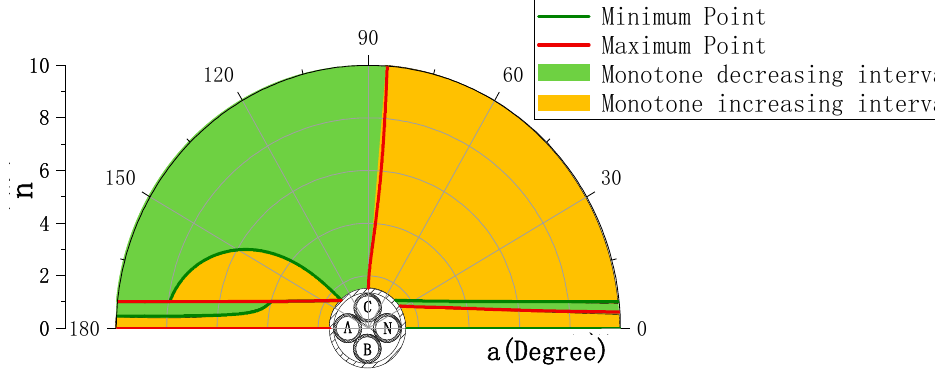
Figure 4. Simulation of the distribution of extremes, and monotonic intervals with “n”.